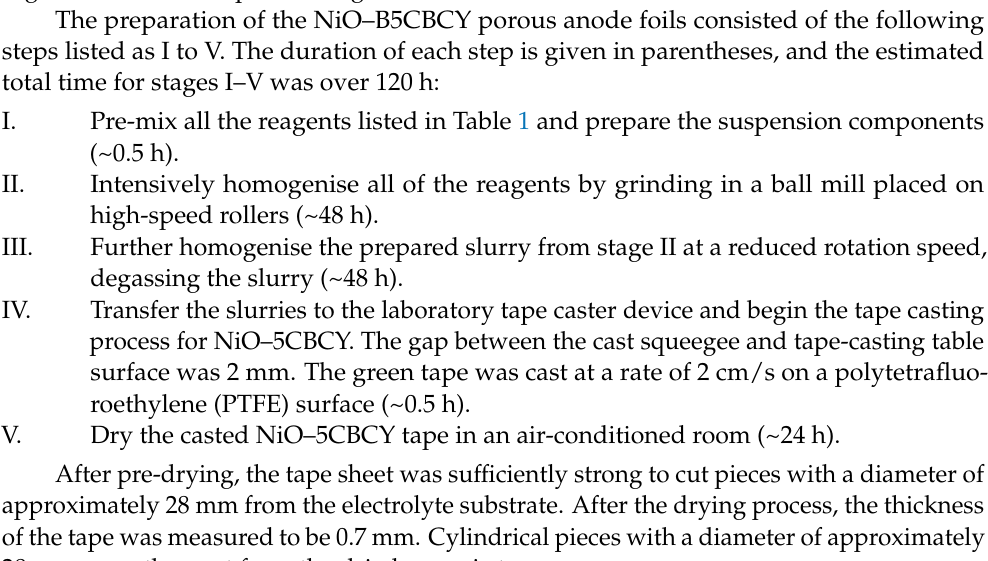
Component Mass/g BC5CY electrolyte powder 38 Nickel (II) oxide 57 Graphite 5 Organic